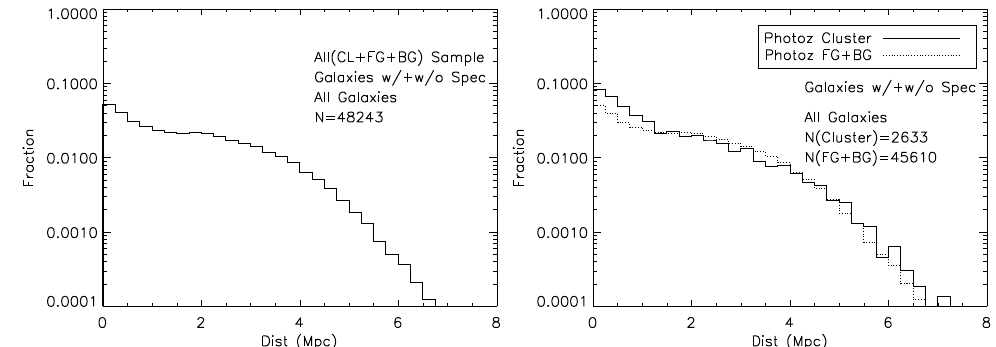
Figure 11. Galaxy distribution free from the spectroscopic sampling bias. Total sample distribution as a function of cluster-centric distance ( left panel) and cluster memberships assigned by photometric redshifts ( right panel), both corresponding to our sample with or without spectroscopy. Namely, our Subaru catalog is matched only with photometric redshift catalog.